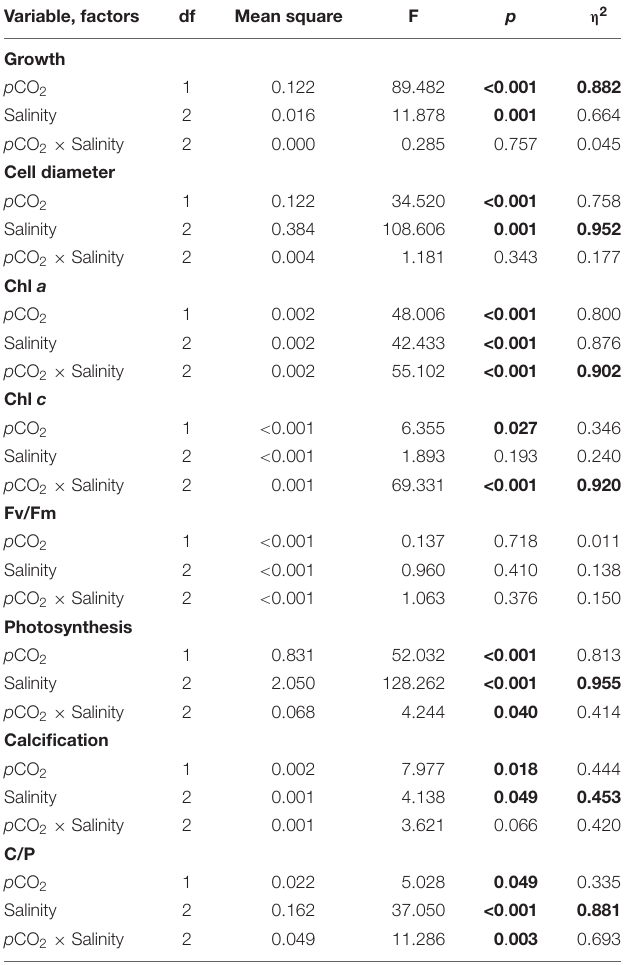
TABLE 2 | Summary of Two-way ANOVA analyses for interactive effects of p CO 2 and salinity on growth, photosynthesis, calcification, pigments, and quantum yield in E. huxleyi